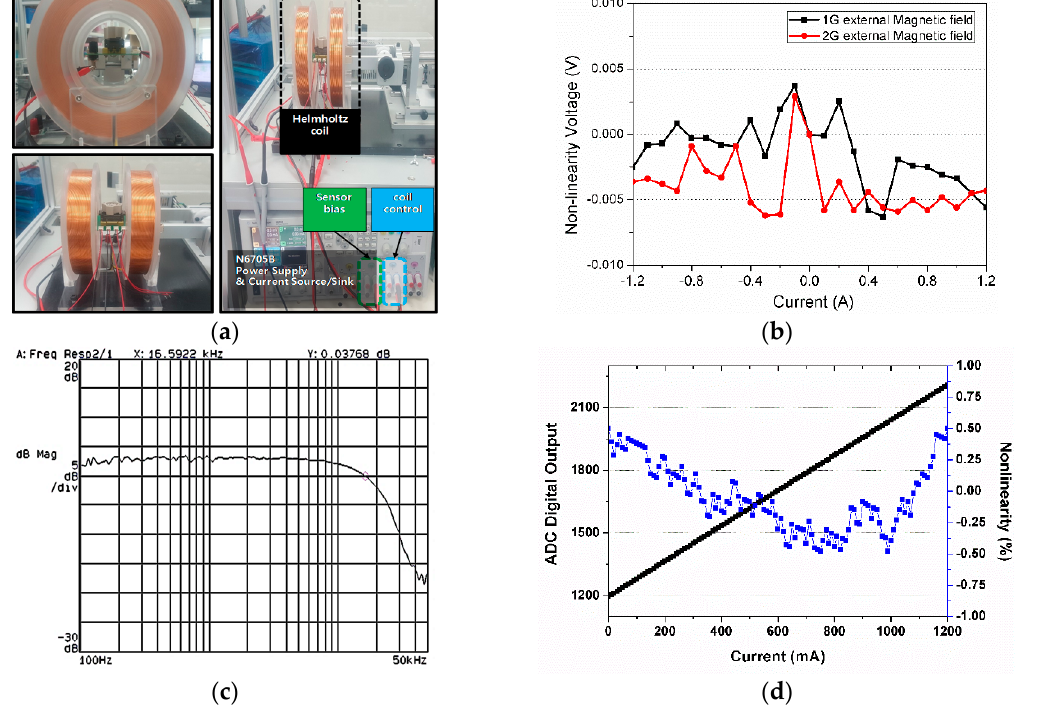
Figure 8. ( a ) The test setup with a Helmholtz coil, ( b ) the measured nonlinearity under an external magnetic field, ( c ) the measured frequency response, and ( d ) the measured current linearity.